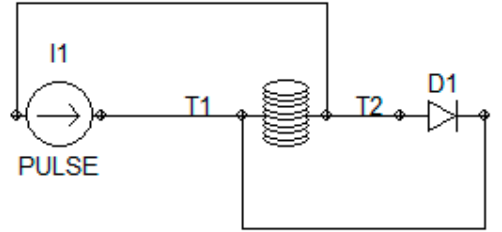
Figure 3. Excitation winding connection. Damper winding is short-circuited at the ends of the bars by copper segments of negligible resistance (Figure 4).